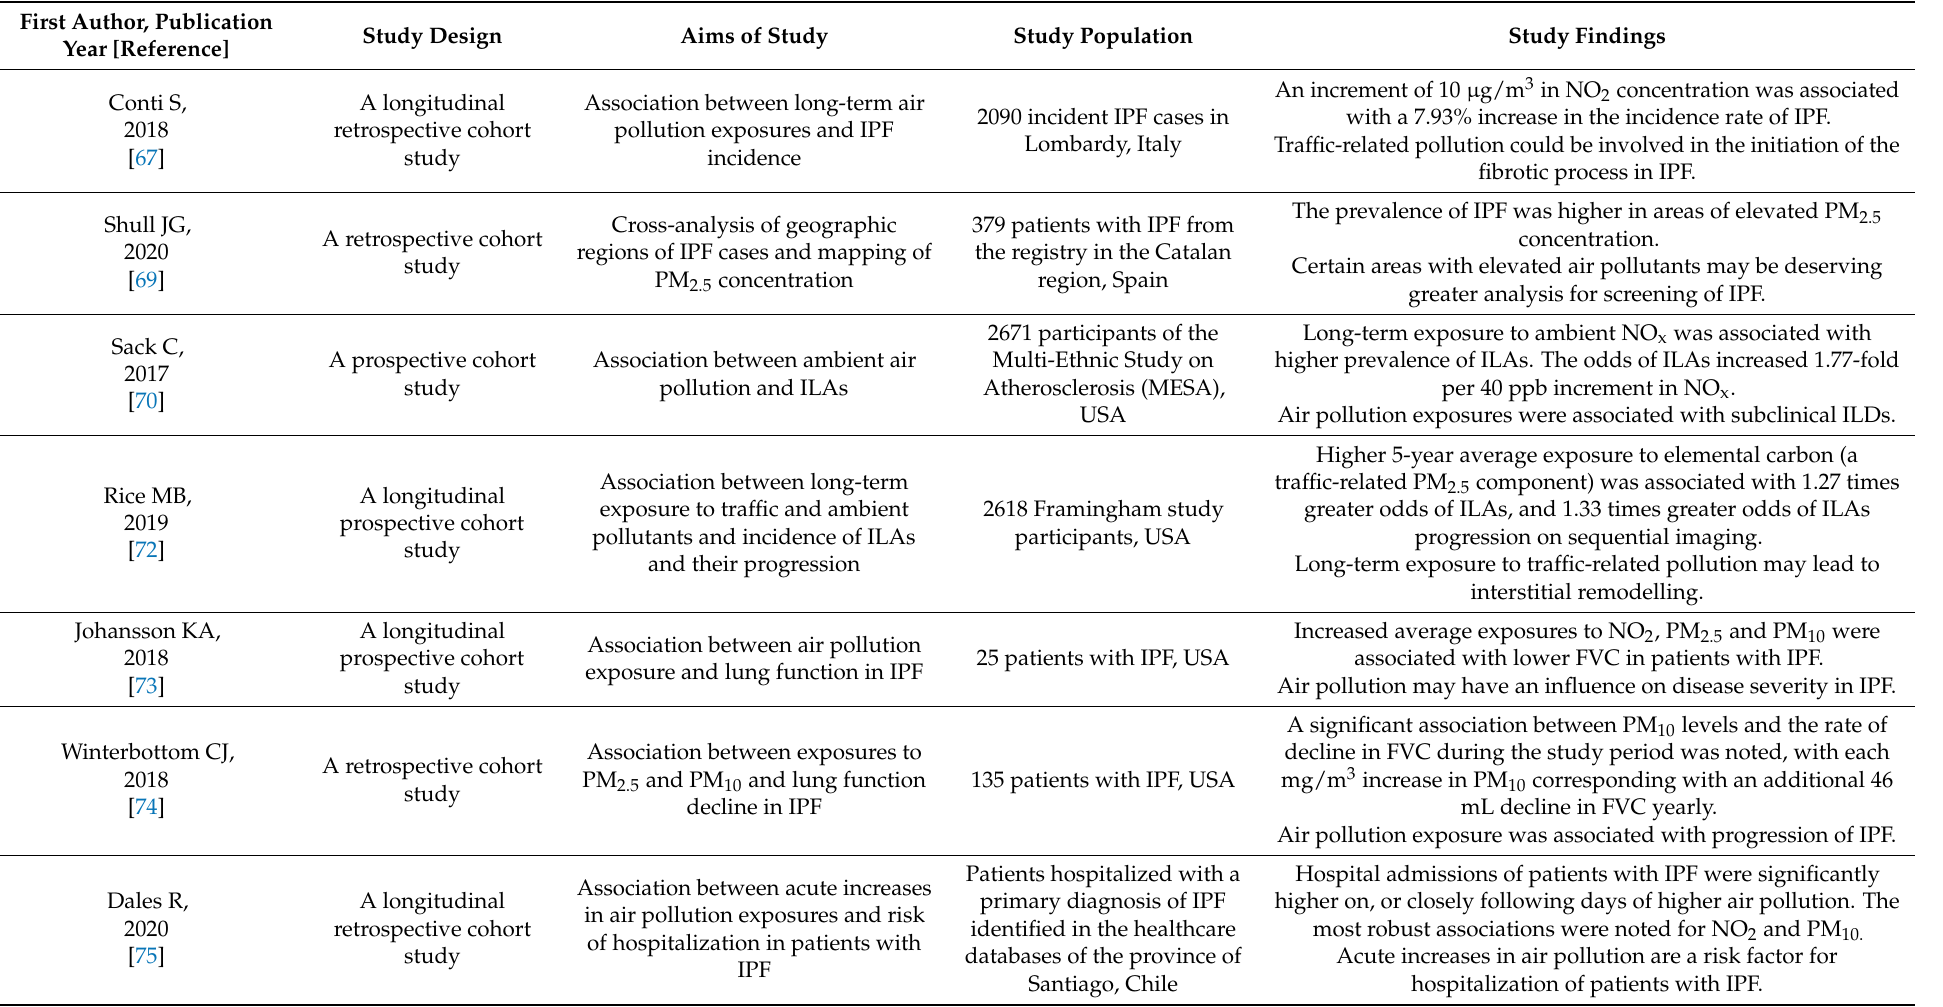
Table 1. Summary of studies linking air-pollution exposure with disease initiation and health outcomes in